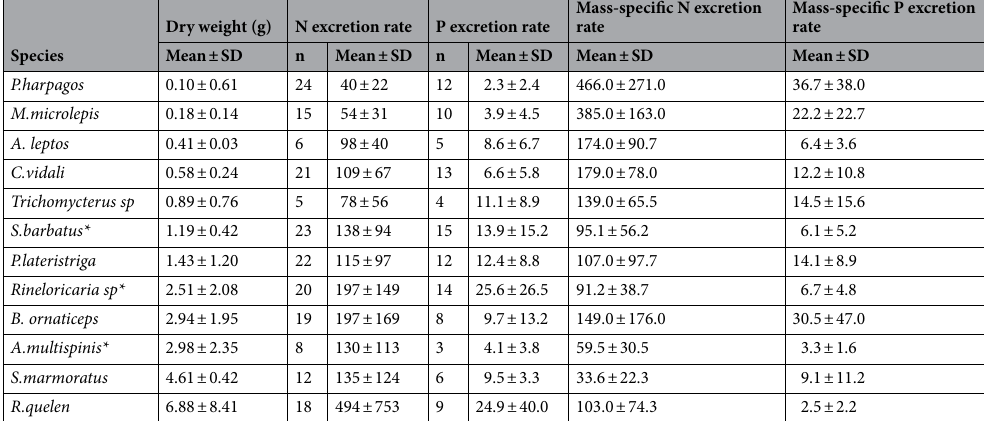
Table 1. Mean per capita excretion rates (µg ind −1 h −1 ) and mass-specific excretion rates (µg g −1 h −1 ) of NH 4 -N and SRP-P of all studied fish species. *Armored catfish—fish of the family Loricariidae and Callichthyidae, named for the rows of overlapping bony plates that cover and protect their bodies.